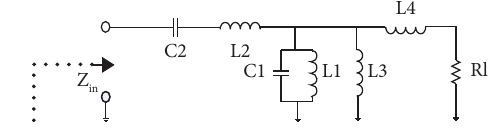
Figure 30: Adding matching circuit on the base of Figure 29.